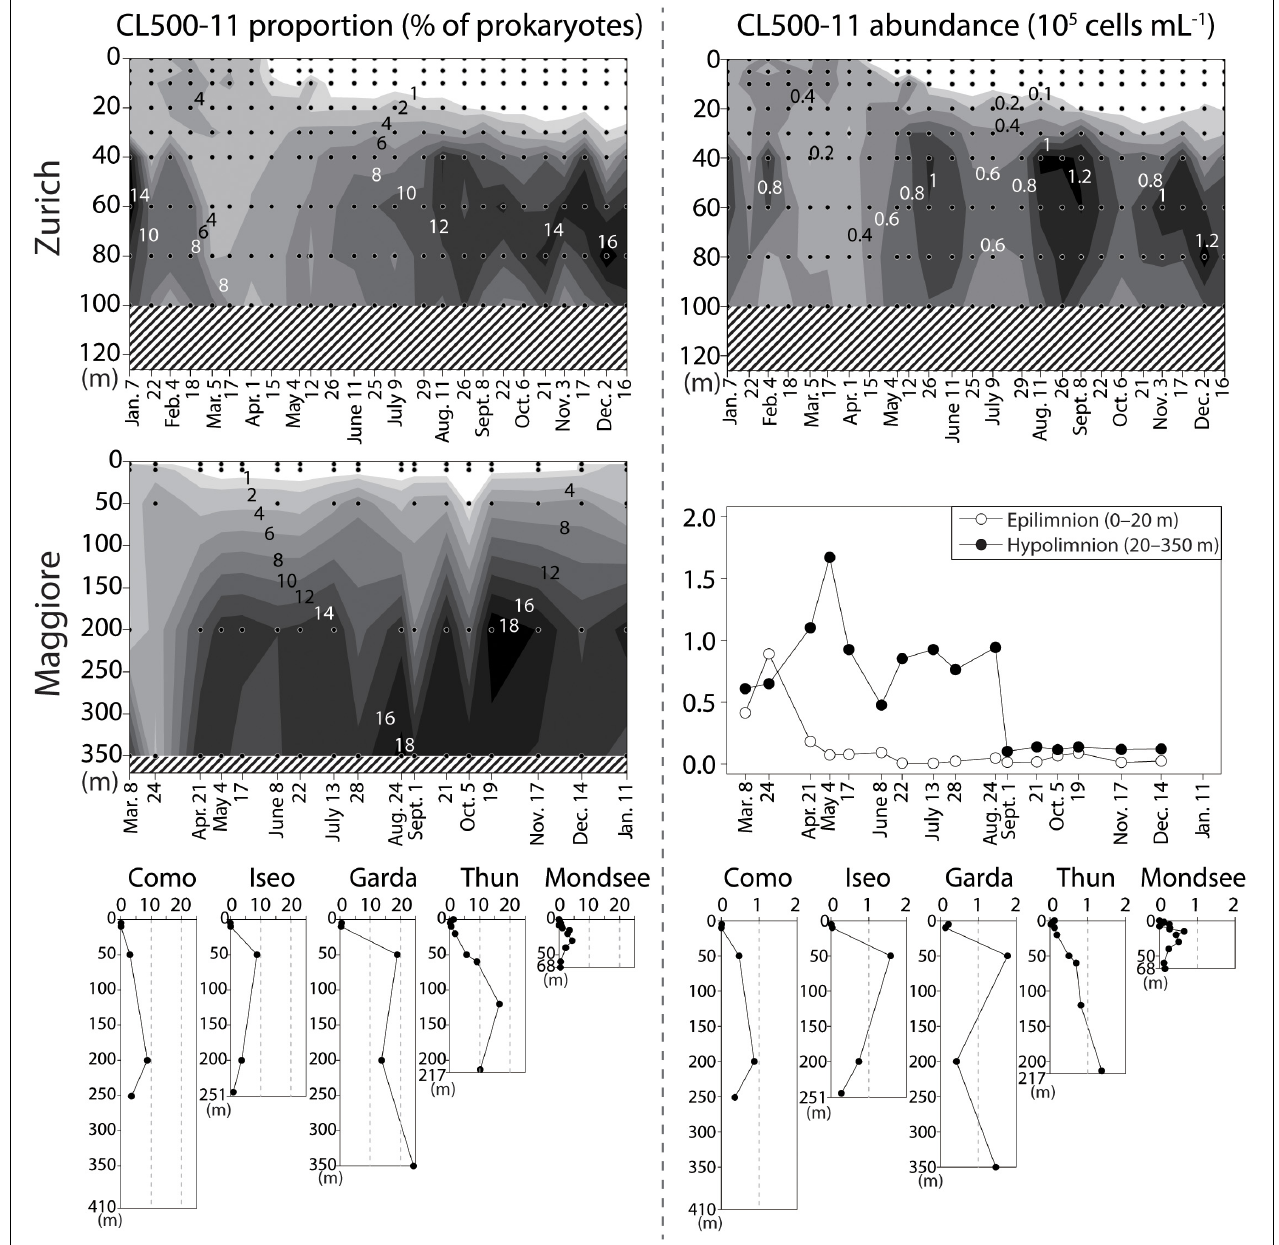
FIGURE 4 | Proportions of CL500-11 in percentage of total prokaryotes (FISH-positive vs. DAPI-stained cells) ( left ; %) and their absolute abundances ( right ; 10 5 cells mL − 1 ) generated by multiplying relative proportions with total prokaryotic abundances ( Figure 2 ). The vertical axes indicate water depth. For Lake Zurich and Maggiore, spatio-temporal measurements are shown by contours. Dots indicate sampling depths and dates, shaded areas missing measurements. In Lake Maggiore, since total prokaryotic abundances were determined in the integrated epilimnetic (0–20 m) and hypolimnetic (20–350 m) samples ( Figure 2 ), the averaged percentage for each layer was used to generate average CL500-11 abundances for epi- and